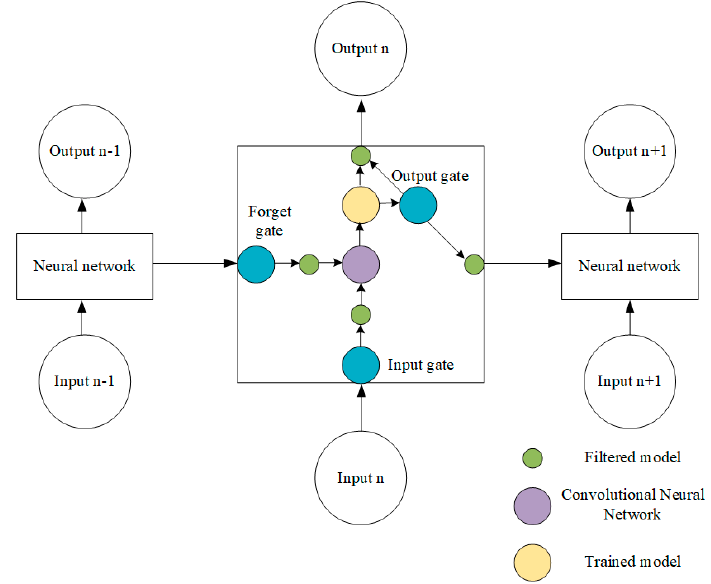
Figure 9. The structure of the Long Short-Term Memory (LSTM) neural network.